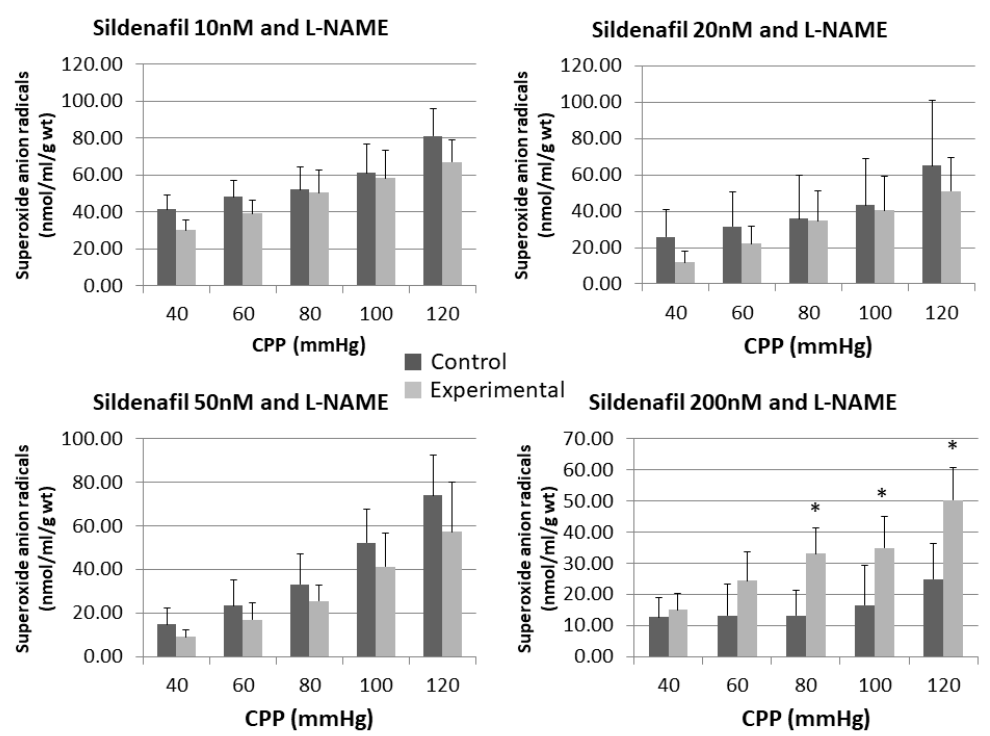
Figure 6. Influence of different sildenafil doses + L-NAME on the dynamics of released superoxide anion radical (O 2 − ) in the isolated rat heart. * p < 0.05, Mixed between-within subject ANOVA; Tukey’s HSD.